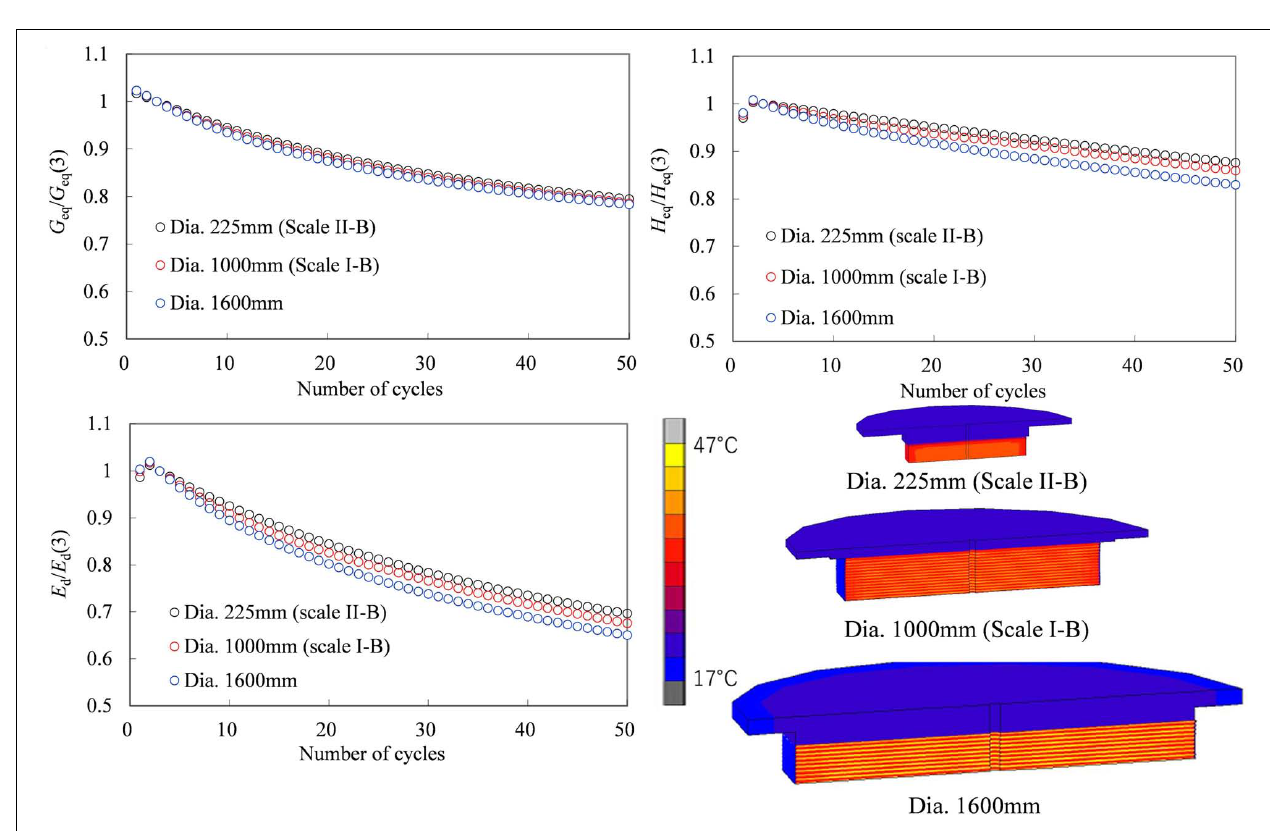
FIGURE 13 | Comparison of change in G eq , H eq , and E d of isolators with diameter of 225 mm (scale-II-B). 1000 mm (scale I-B), and 1600 mm in repeated loading by FEA.